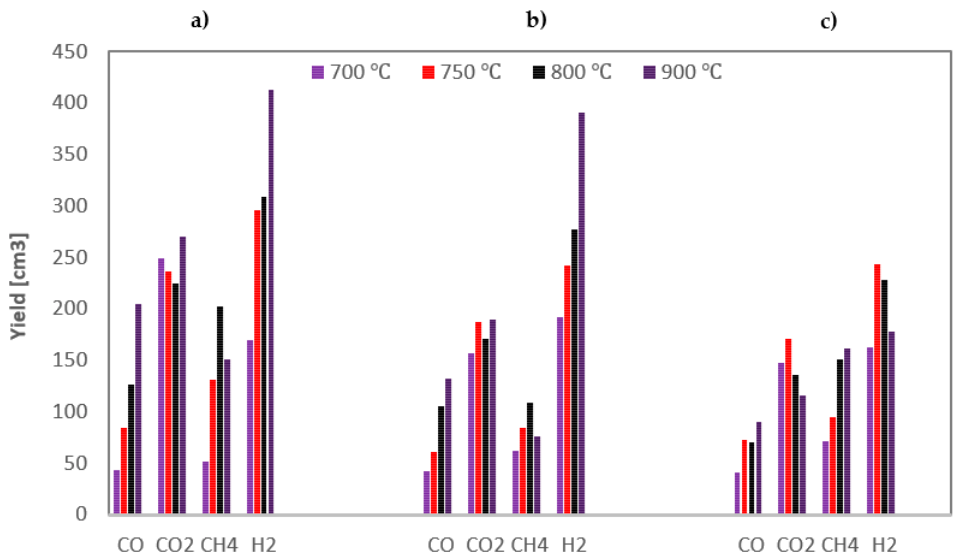
Figure 4. Yields of gas components formed during steam gasification of RDF at various tempera- tures and under: ( a ) 0.5 MPa; ( b ) 1 MPa; ( c ) 1.5